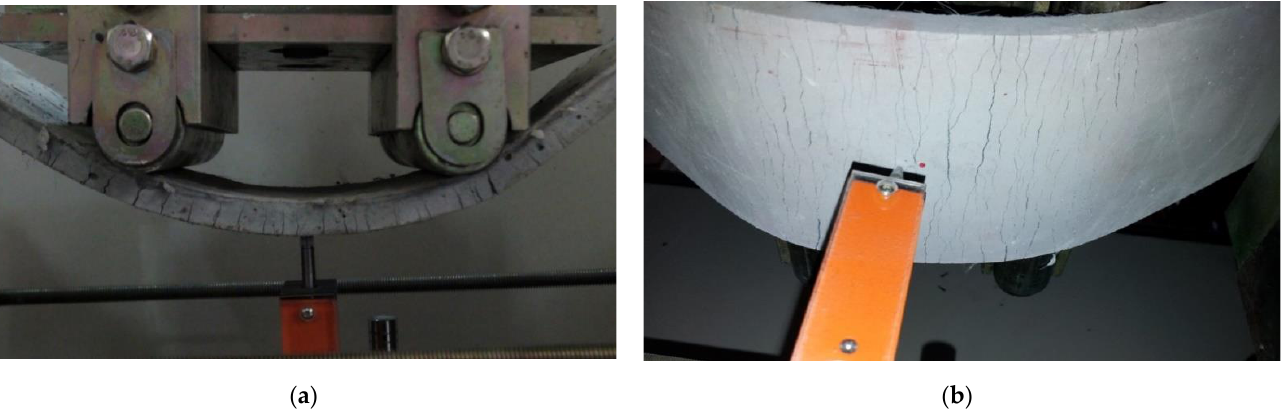
Figure 10. Multiple microcracks in bending test: ( a ) ASFC100 (PVA 1.00 vol.%); ( b ) ASFC150 (PVA 1.50 vol.%).